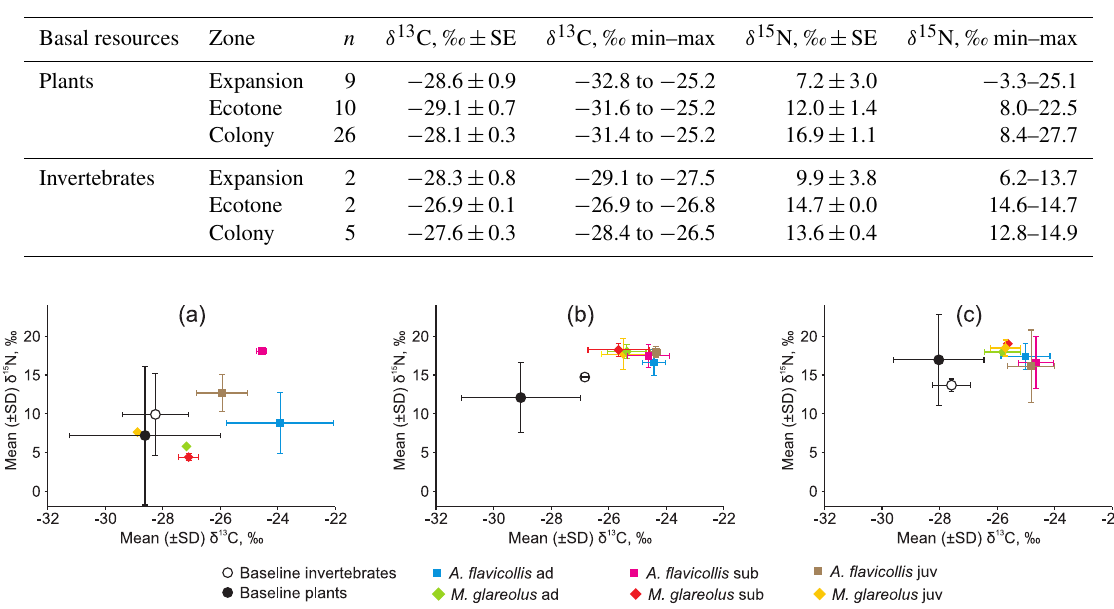
Table 3. Isotopic signatures of basal resources (plants and invertebrates) in the Juodkrant˙e great cormorant colony, ecotone and expansion zones in 2015.